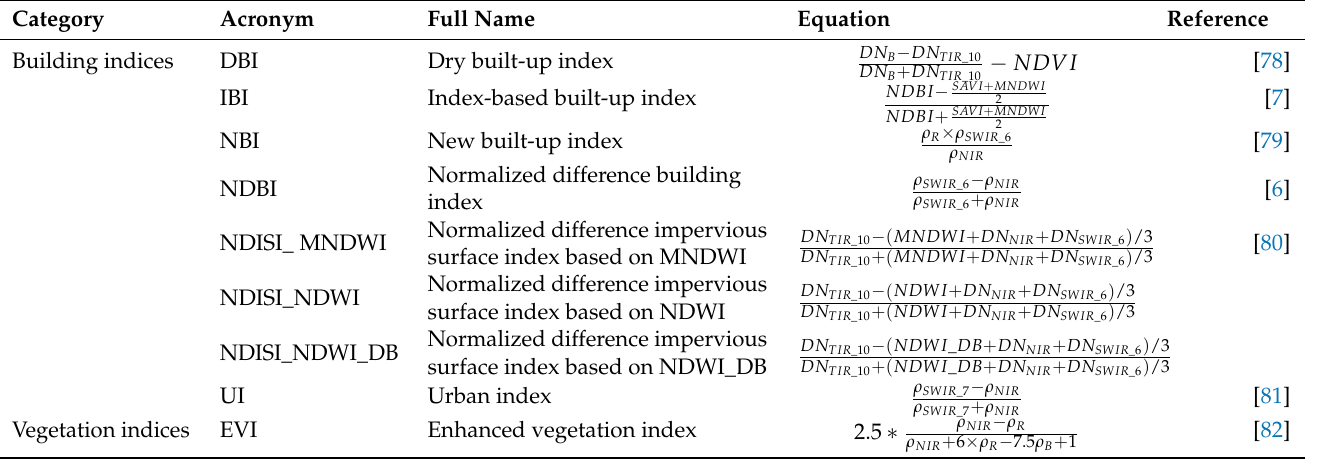
Table 3. Equations for the selected nineteen land-use/land-cover